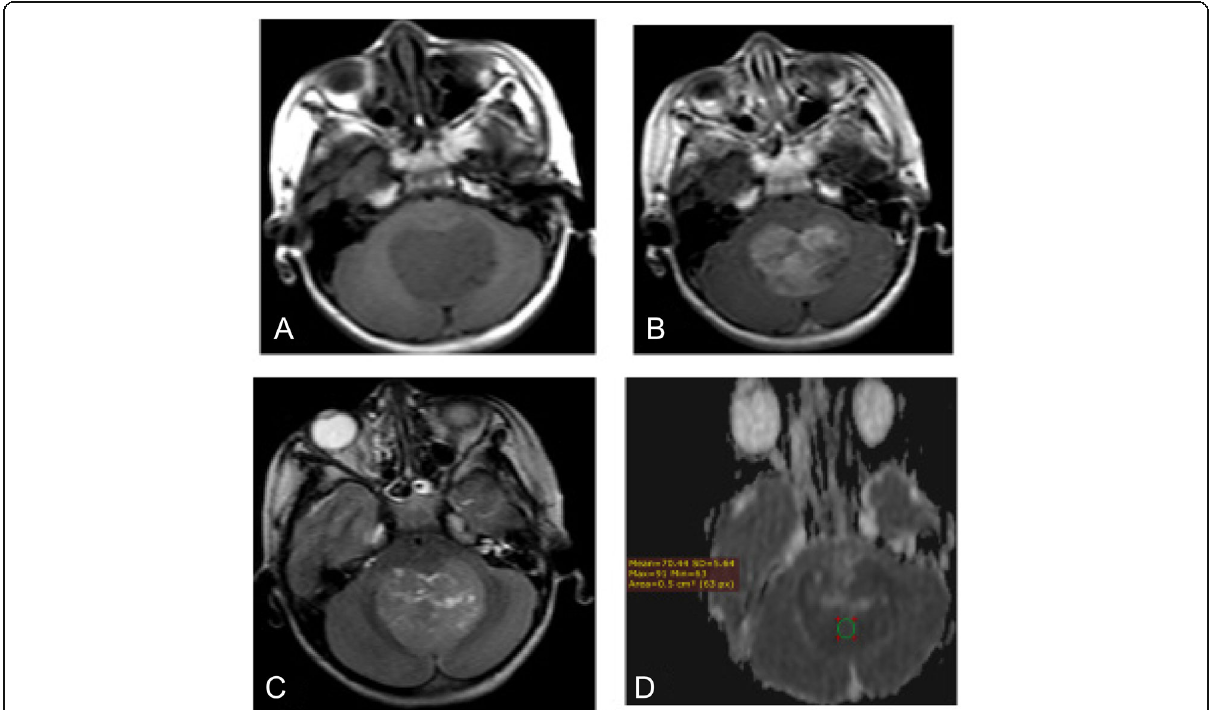
Fig. 3 Typical MRI features of a medulloblastoma in a 3-year-old child who presented with chronic headache 5 months ago. a T1WI shows midline vermian hypointense mass in the posterior fossa causing anterior displacement of the fourth ventricle. b T2WI: the mass appears isointense to slightly hyperintense. Few T1WI hypointense and T2WI hyperintense foci suggestive of cystic components. c Post-contrast T1WI axial image showing intense enhancement of the mass. d Low signal on apparent diffusion coefficient images (ADC), features suggestive of restricted diffusion corresponding to hypercellularity of the